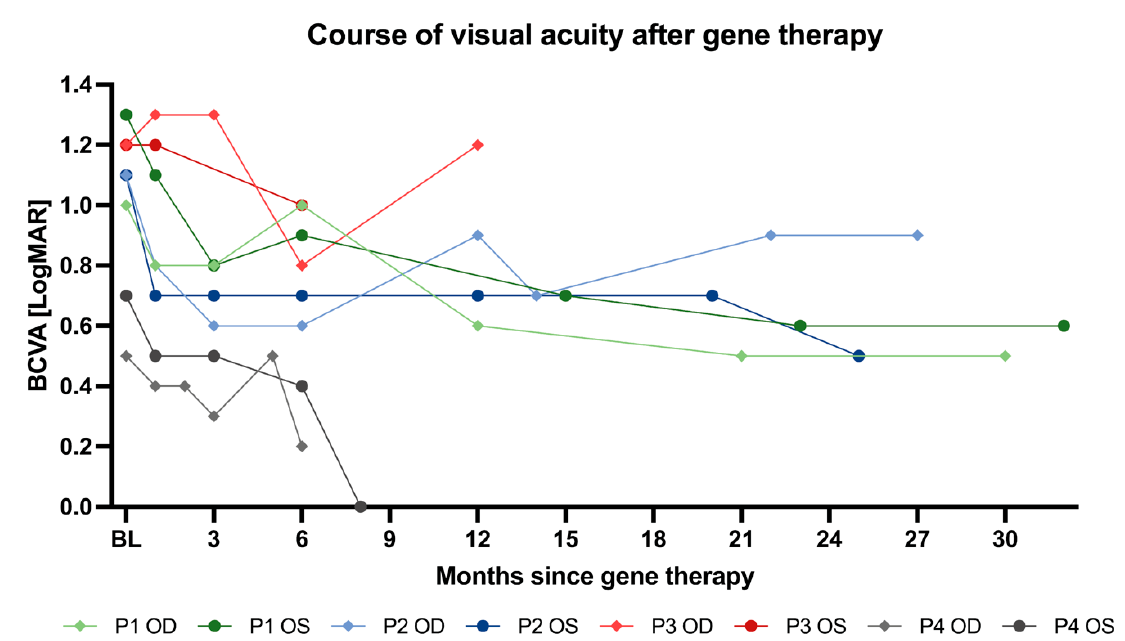
Figure 3. Course of visual acuity after gene therapy with voretigene neparvovec. Course of best corrected visual acuity (BCVA) of each treated eye is shown ranging from a minimal postoperative follow up time of 6 months ( n = 8) up to 32 months ( n = 1). Table 3. Changes of best corrected visual acuity from baseline up to 6 months.